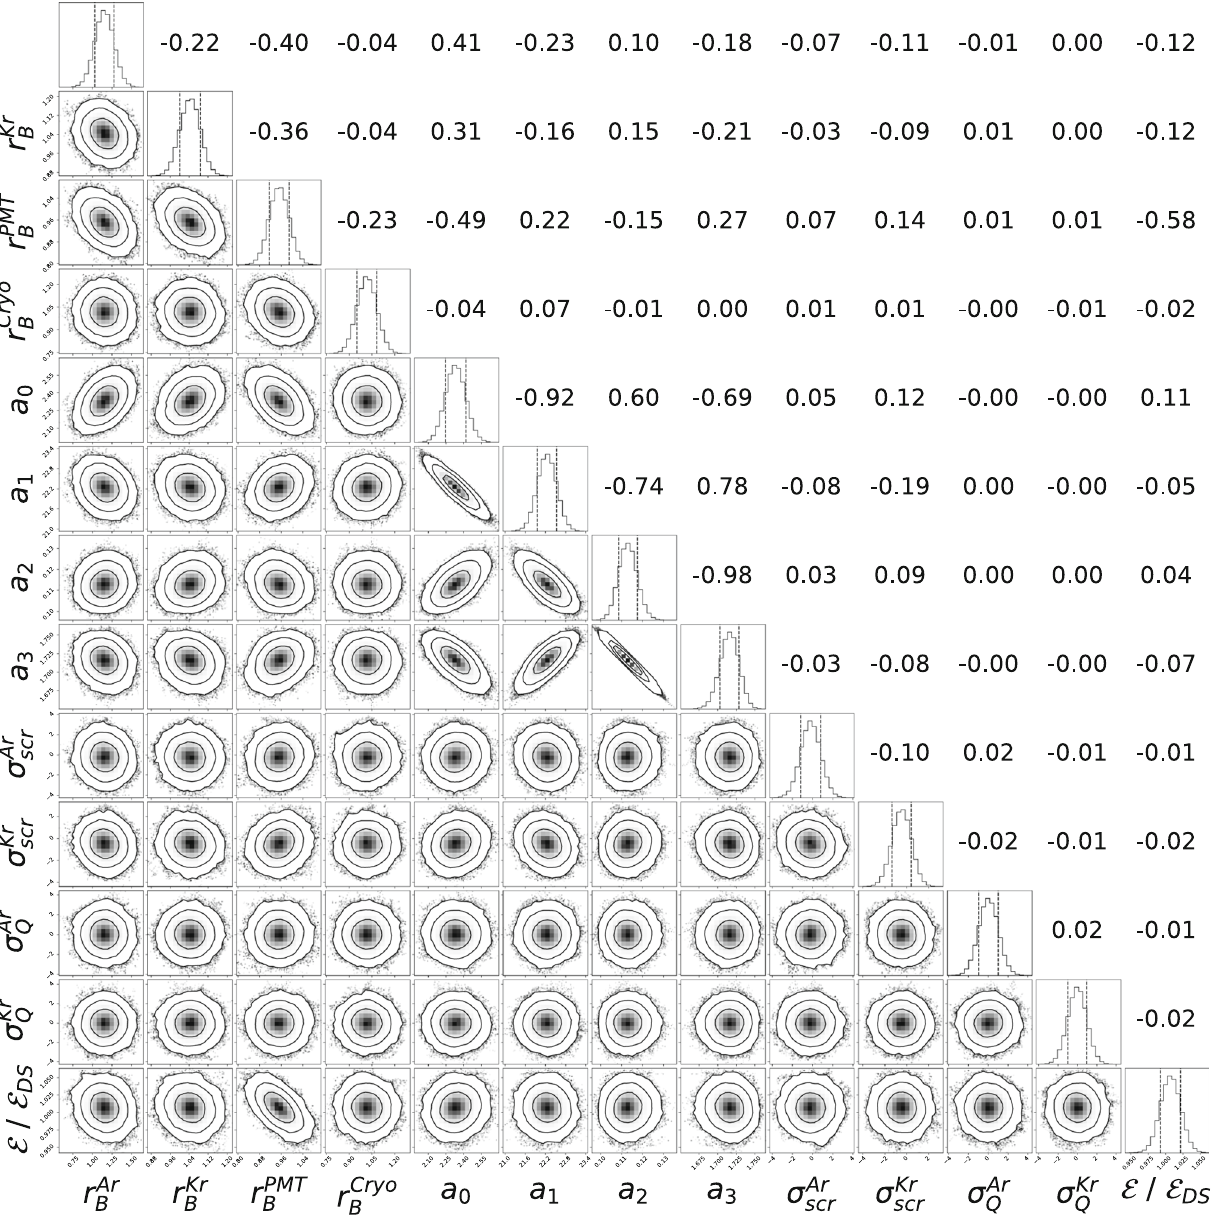
parametersobtainedbymarginalizingontheothers.Theplotsshowalso the credible regions at 68% , 95% , 99 . 7% probability as solid contour lines. The correlation coefficients are given in the upper-right corner of the